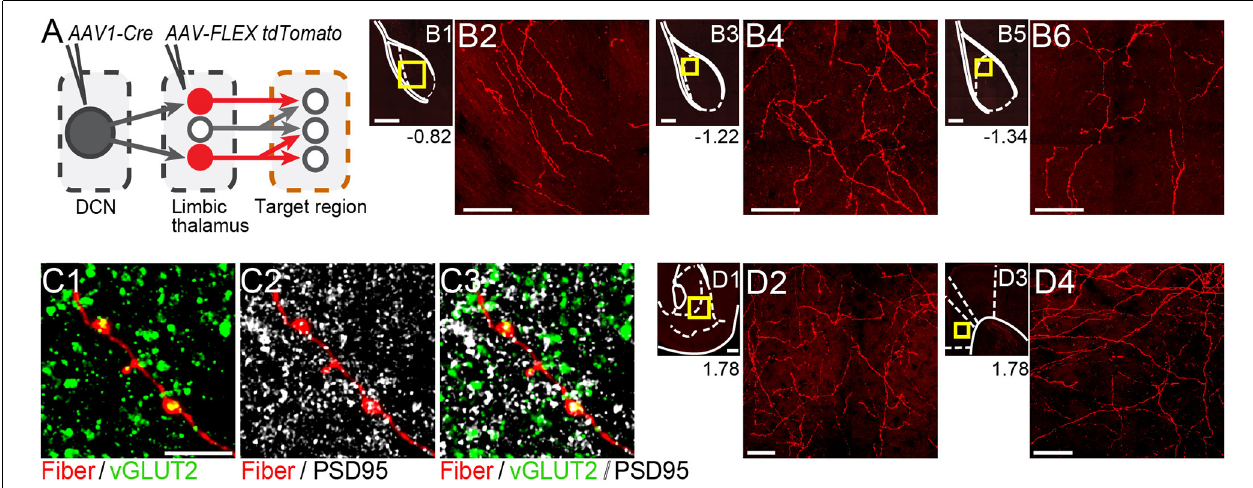
FIGURE 4 | Thalamic neurons receiving cerebellar input form synapses in the basolateral amygdala and also target the nucleus accumbens and prelimbic cortex. (A) Schematic diagram of the experimental approach. Targets of tdTomato+ axons of thalamic neurons receiving cerebellar input were identified through imaging. (B) Mosaic confocal images of tdTomato+ axons along the anterior-posterior axis of the BLA. (C) High resolution airyscan confocal images of tdTomato+ axons in the BLA colocalizing with presynaptic (vGLUT2) (C1) and postsynaptic (PSD95) (C2 ) markers of excitatory synapses. Green: vGLUT2, gray: PSD95, yellow/white in (C3) : overlay. (D) tdTomato+ axons in nucleus accumbens (D1,D2) and prelimbic cortex (D3,D4) . Yellow squares in (B1,B3,B5,D1,D3) show zoom-in areas for (B2,B4,B6,D2,D4) images, respectively. Numbers at the bottom of images indicate the distance (in mm) from bregma. Scale bars: (B1,B3,B5,D1,D3) : 200 µ m; (B2,B4,B6,D2,D4) : 50 µ m; (C1–C3) : 5 µ